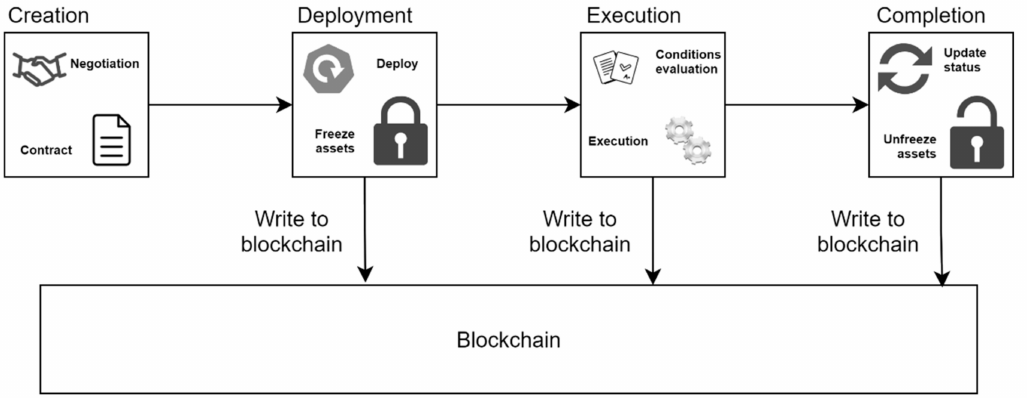
Figure 9. Smart contract